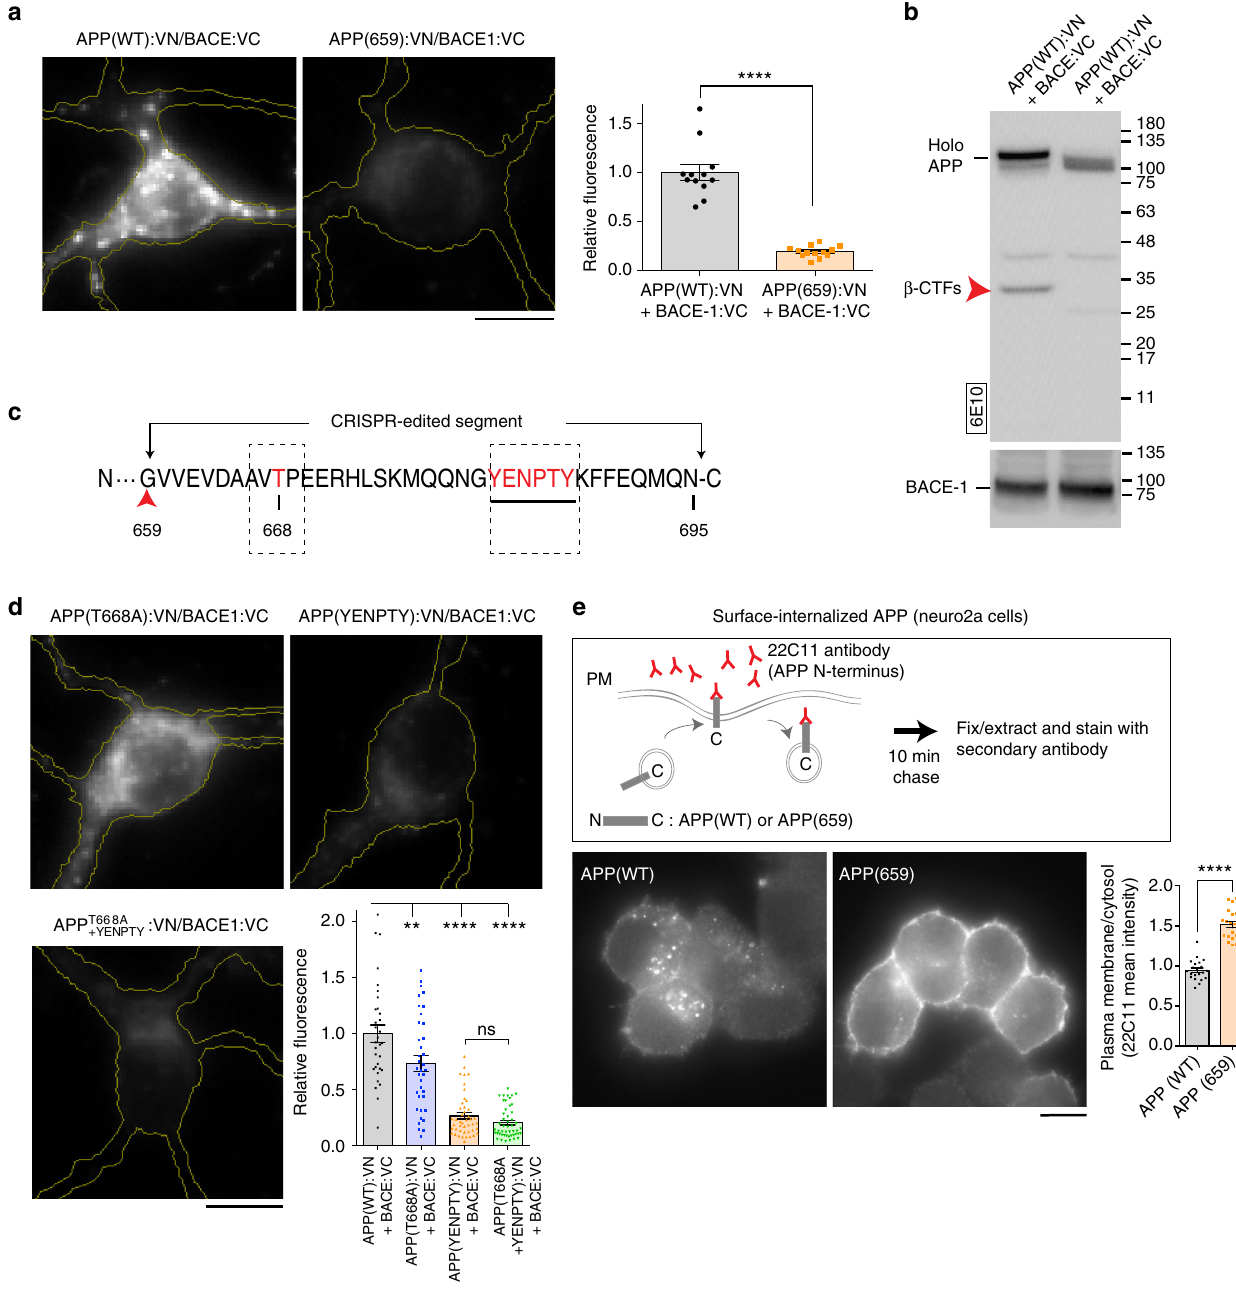
Fig. 5 Mechanistic details of CRISPR-guided APP editing. a APP/BACE-1 interaction — as evaluated by fl uorescence complementation in cultured hippocampal neurons — was attenuated in neurons transfected with an APP C-terminus truncation mimicking the post-edited translational product (APP659:VN; quanti fi ed below, mean ± SEM of 12 cells for APP(WT) and 13 cells for APP(659) from two independent experiments, p < 0.0001 by two- tailed t -test). Scale bar 10 μ m. b APP β -cleavage is also attenuated in cells transfected with APP659. HEK cells were co-transfected with APPWT (or APP659) tagged to VN, and BACE-1:VC; and immunoblotted with the 6E10 antibody. Note decreased β -CTFs in cells carrying the truncated APP plasmid. c Schematic showing the CRISPR-edited C-terminus portion of APP. Note that the threonine at 668 position, and the endocytic YENPTY motif (dashed boxes) are thought to play roles in A β production (see text). d APP/BACE-1 interaction — as evaluated by fl uorescence complementation in cultured hippocampal neurons — was most markedly attenuated in neurons transfected with mutant YENPTY (mean ± SEM of 32 cells for APP(WT), 37 cells for APP (T668A), 45 cells for APP(YENPTY) and 49 cells for APP(T668A + YENPTY) from two independent experiments). One-way ANOVA: p < 0.0001. Tukey ’ s multiple comparisons: p = 0.0022 (APP vs. APP T668A ); p < 0.0001 (APP vs. APP YENPTY ); p < 0.0001 (APP vs. APP T668A + YENPTY ); p < 0.0001 (APP T668A vs. APP YENPTY ); p < 0.0001 (APP T668A vs. APP T668A + YENPTY ); p = 0.7568 (APP YENPTY vs. APP T668A + YENPTY ). Scale bar 10 μ m. e Strategy of APP internalization assay. Neuro 2a cells are transfected with APP:GFP or APP659:GFP. After incubation with anti N-terminal APP antibody (22C11) for 10 min, the cells were fi xed and stained with secondary antibody to visualize the cell surface and internalized APP. Note the cell surface accumulation and decreased internalization of APP659 (mean ± SEM of 21 cells from two independent experiments, p < 0.0001 by two-tailed t -test). Scale bar 10 μ m. Source data are provided as a Source Data fi